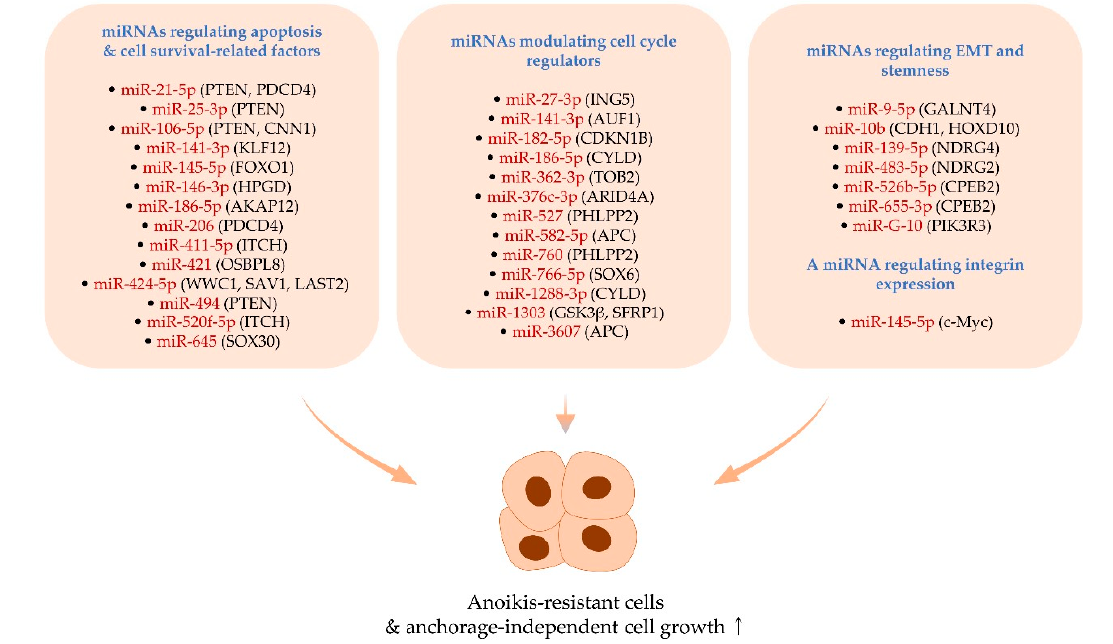
Figure 1. Oncogenic miRNAs (red) and their relevant target genes (black) facilitating anoikis resistance and anchorage- independent cell growth in cancer. It is described in Table 1 and Section 2. Table 1. Oncogenic miRNAs that enhance the anoikis resistance and anchorage-independent growth of cancer. miRNA